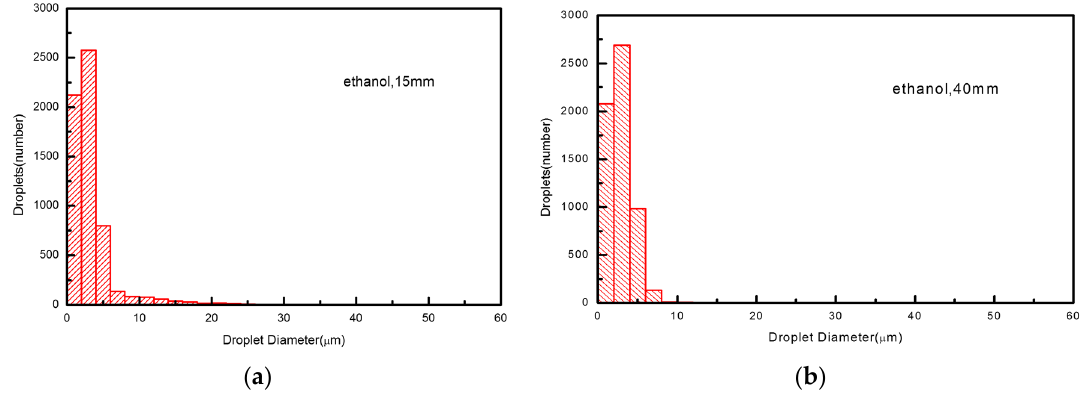
Figure 6. Ethanol droplet size distribution at different cross ‐ sections at 15 mm ( a ) and 40 mm ( b ).